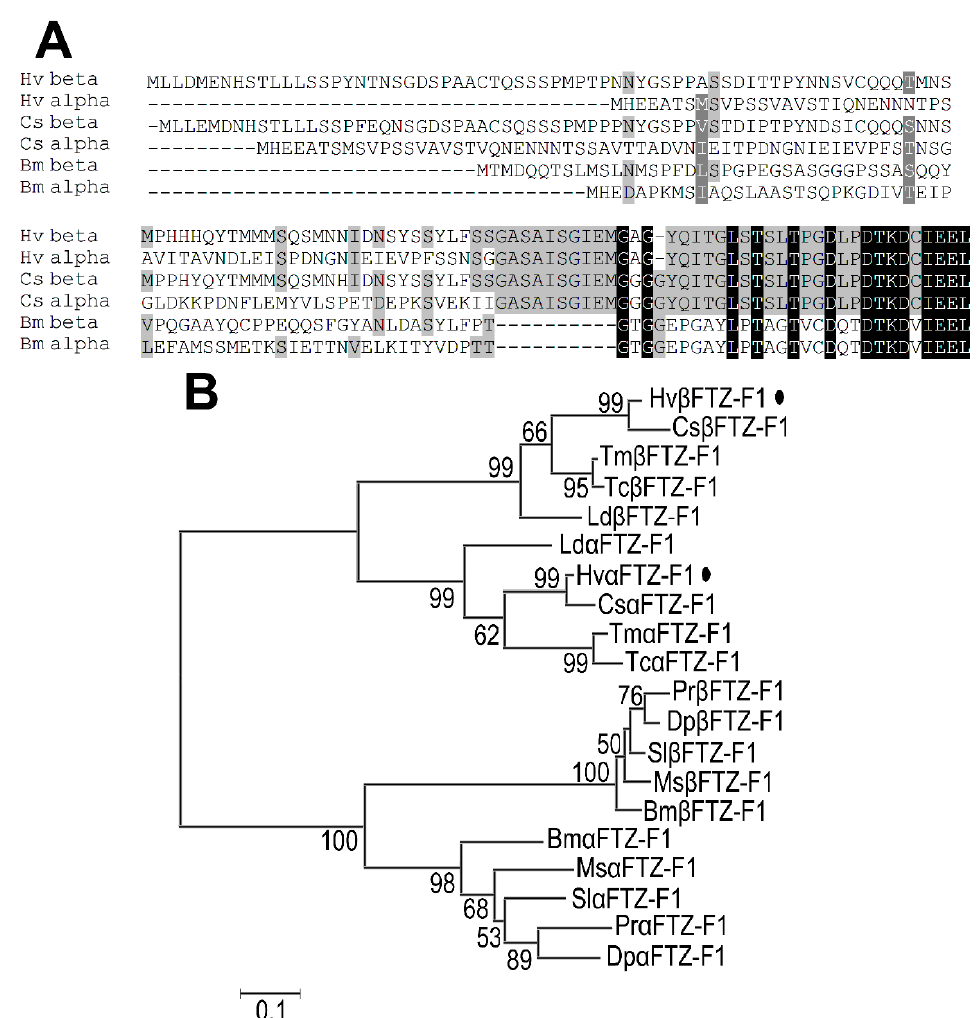
Figure 2. Alignment ( A ) and phylogenetic analysis ( B ) of the unique N-terminal A/B domains of FTZ-F1s. ( A ) Sequence alignment of the A/B-domains. Increasing background intensity (from light to dark) indicates an increase in sequence similarity. Gaps were introduced to permit alignment to be obtained. ( B ) The A/B domains of the FTZ-F1 proteins are derived from five Coleopteran, i.e., H. vigintioctopunctata (Hv), Coccinella septempunctata (Cs), Tribolium castaneum (Tc), Tribolium madens (Tm) and Leptinotarsa decemlineata (Ld), and five Lepidopteran, i.e., Pieris rapae (Pr), Danaus plexippus (Dp), Spodoptera litura (Sl), Manduca sexta (Ms) and Bombyx mori (Bm). The A/B domains of the FTZ-F1 proteins are marked with black dots. See Table 1 for the details of the FTZ-F1 protein sequences. The tree was constructed using the neighbor-joining method based on the A/B-domains protein sequence alignments. Bootstrap analyses of 1000 replications were carried out and bootstrap values >50% are shown on the tree.